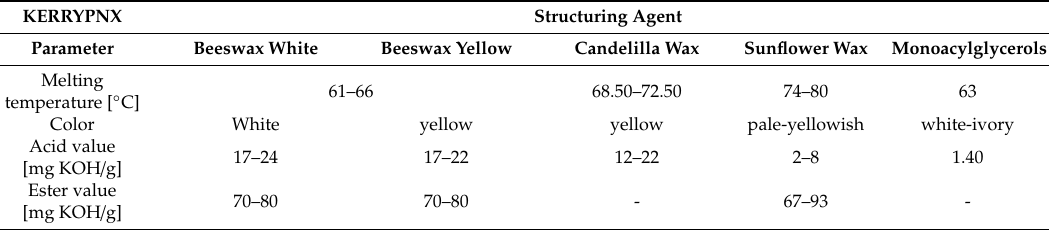
Table 1. Specification of structuring agents [manufacturer’s